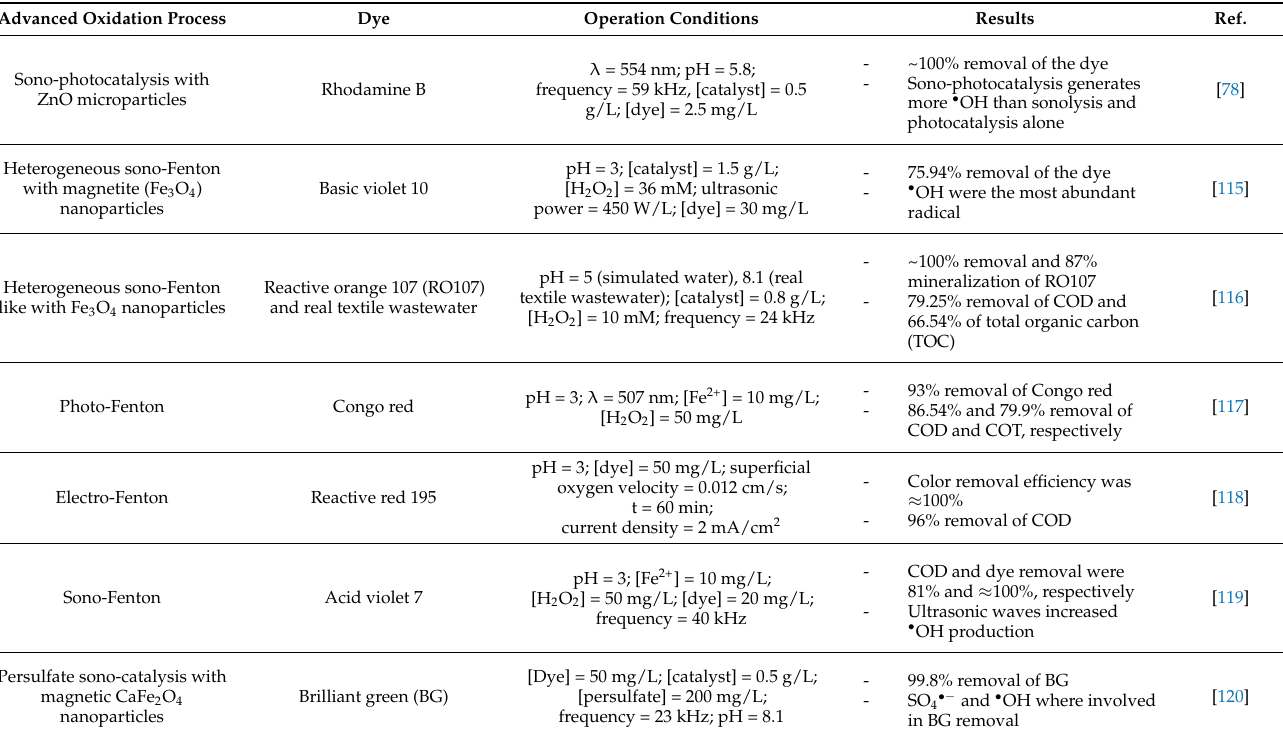
Table 2 lists studies about the treatment of dyes contained in water by using AOPs. Table 2. Dye treatment by using